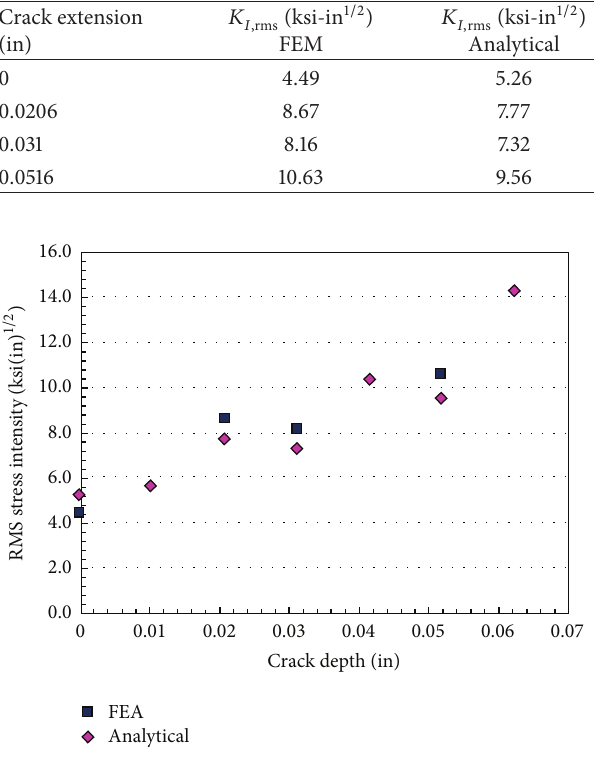
Figure 15: 𝐾 𝐼 along the crack front FEM and analytical